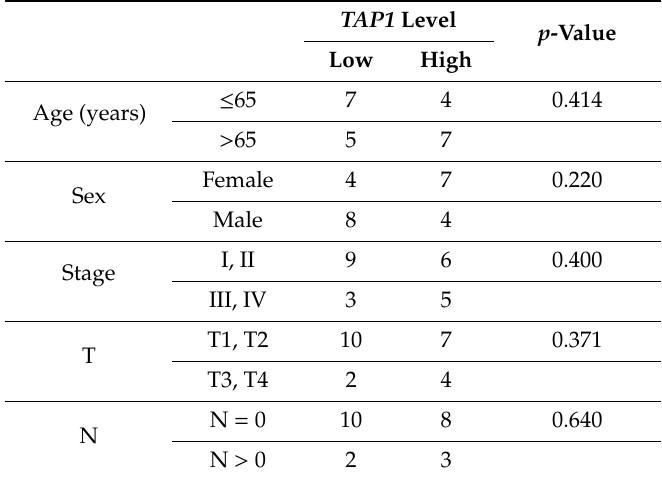
Table 3. Clinical variables and their associations with TAP1 .